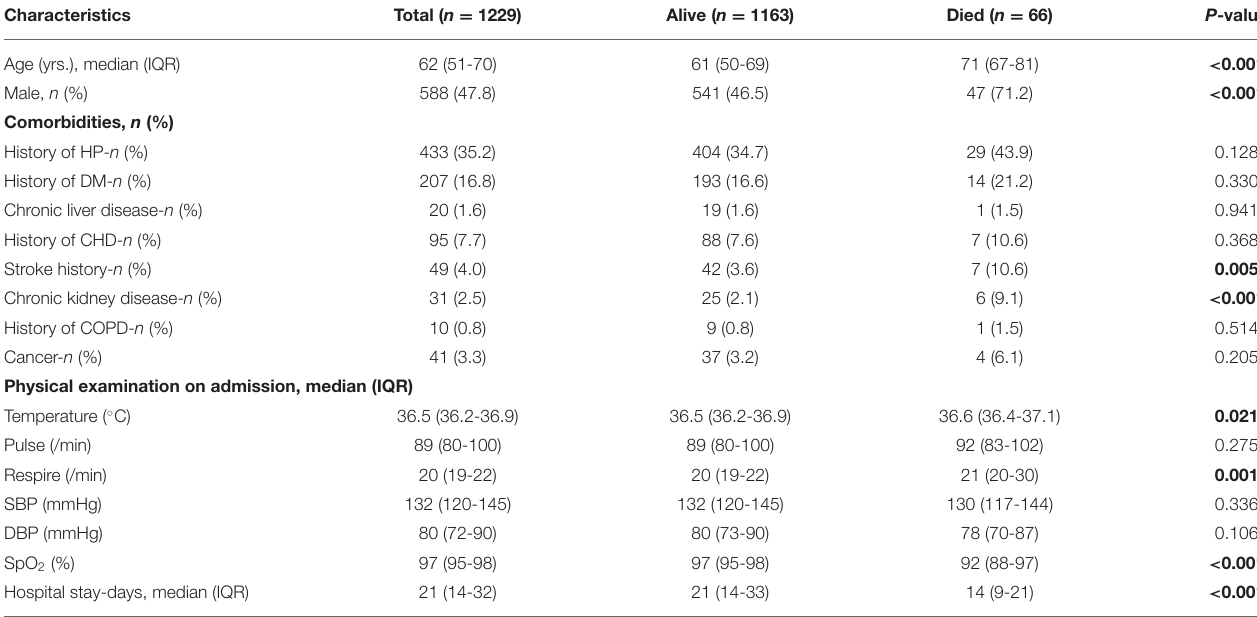
TABLE 1 | Baseline characteristics of the overall study population and patients stratified based on mortality. Characteristics Total ( n =